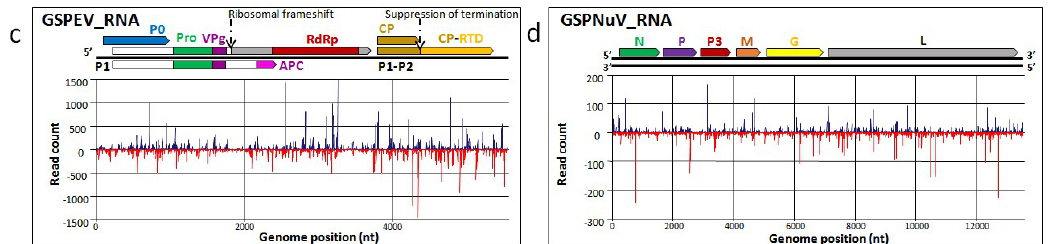
Figure 6. The vsiRNA read distribution across the genome of GSPNeV ( a ), GSPIV ( b ), GSPEV ( c ) and GSPNuV ( d ); the blue lines above the genome and red lines beneath the genome represent mapped genomic and anti-genomic vsiRNAs, respectively.